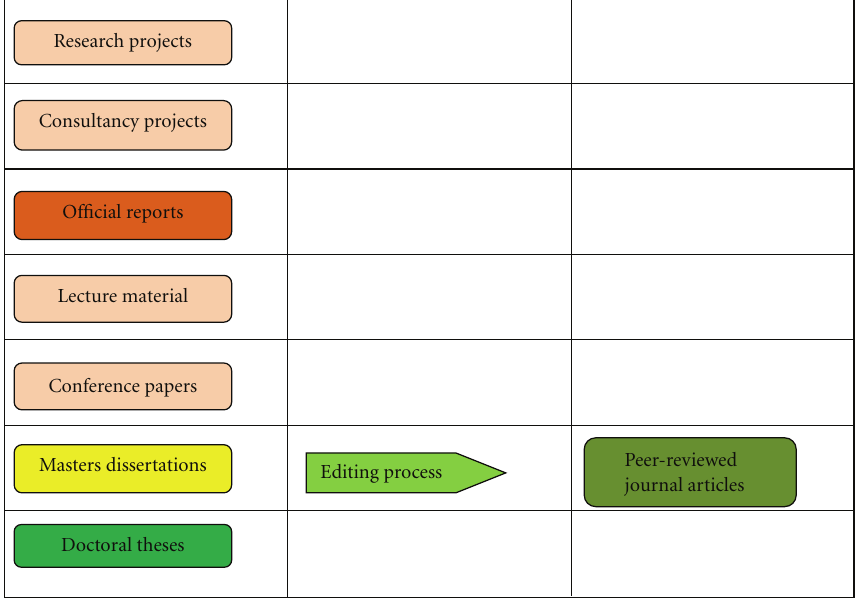
Figure 1: Sources of journal articles.